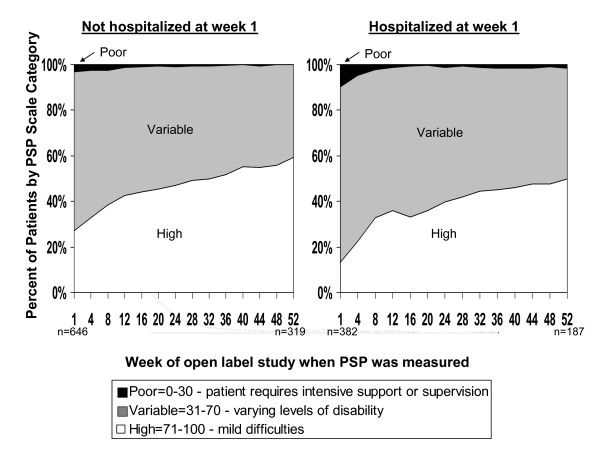
Percentage of patients by Personal and Social Performance (PSP) scale category by week of PSP administration and hospitalization status at week 1 (the start of the open-label phase).